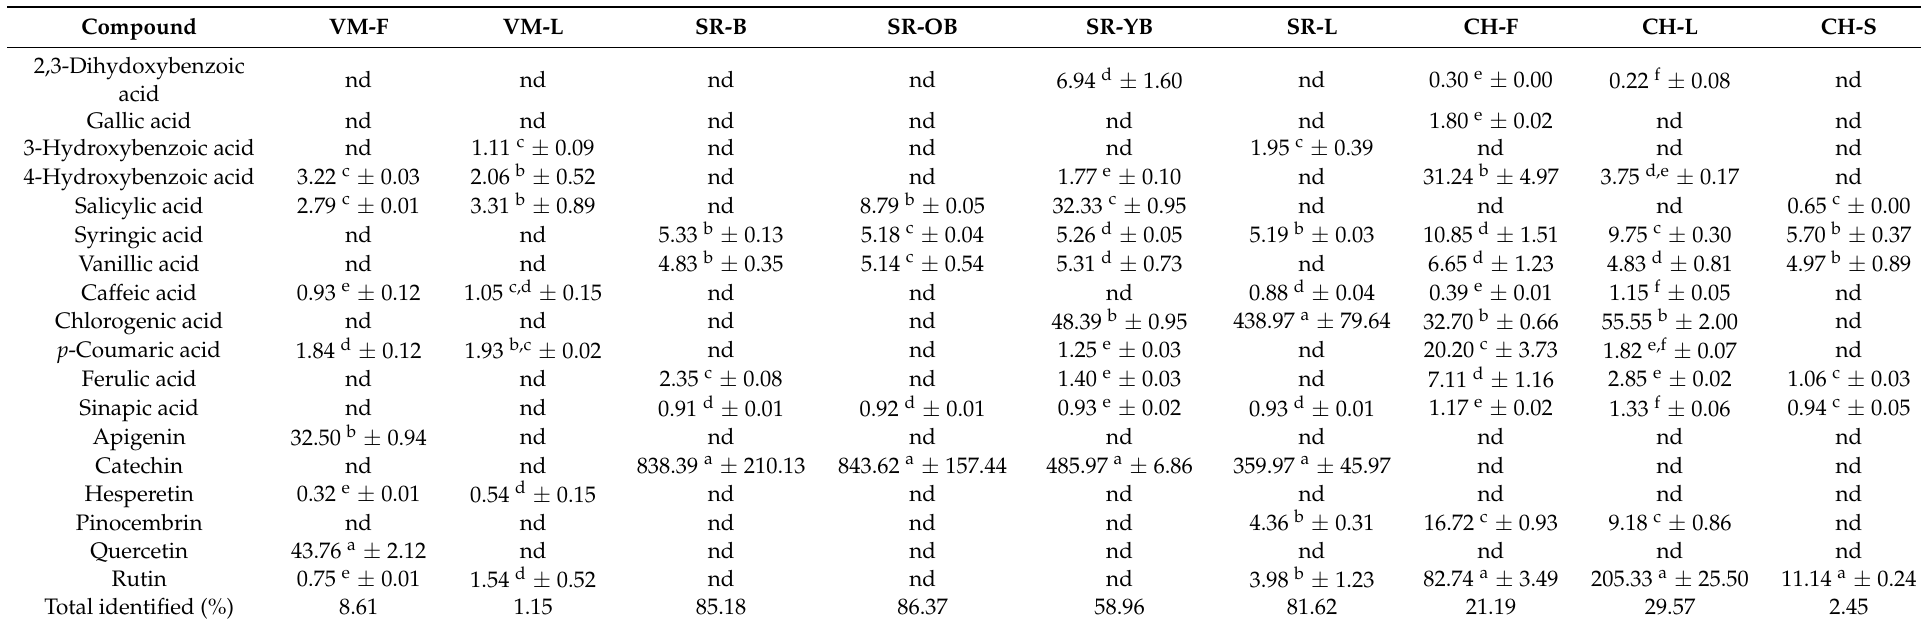
Table 1. Phenolic profiles of investigated plant extracts